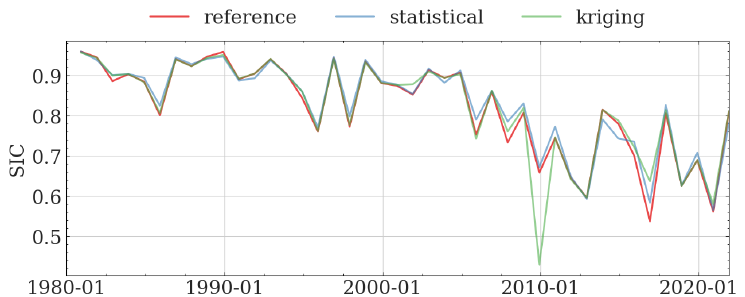
Figure 9. The comparison between kriging and statistical interpolation on SIC in October, November, and